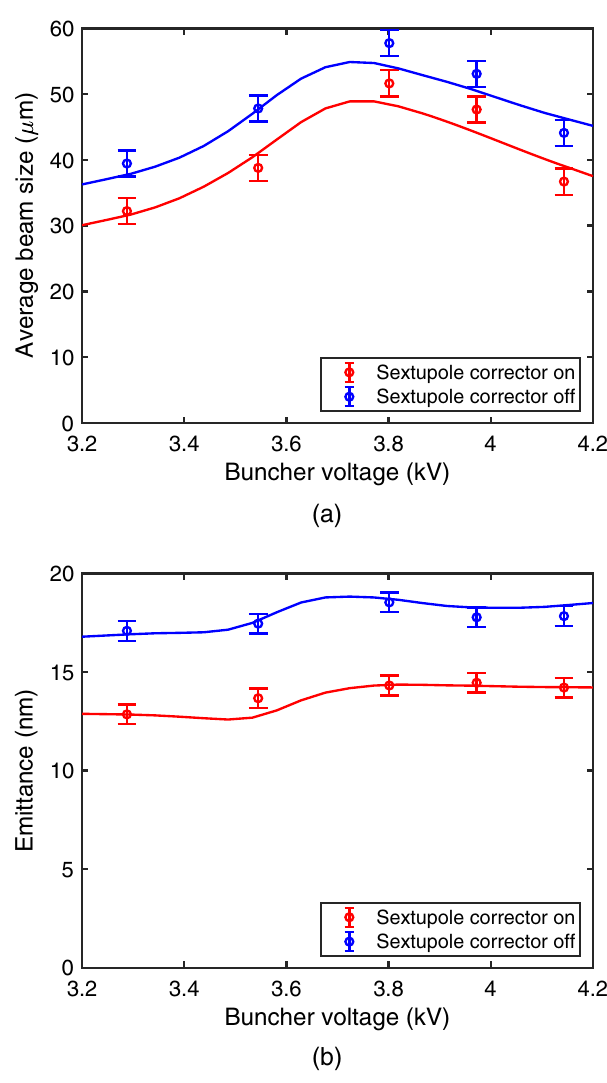
FIG. 8. (a) Spot size and (b) transverse normalized rms emittance for different choices of buncher voltage around the optimal bunching voltage (3.6 kV). The red line comes from simulation results with zero quadrupole or sextupole aberrations. The blue line was made simulating the same beamline with a sextupole added inside of the rf buncher, with a best-fit strength of the sextupole